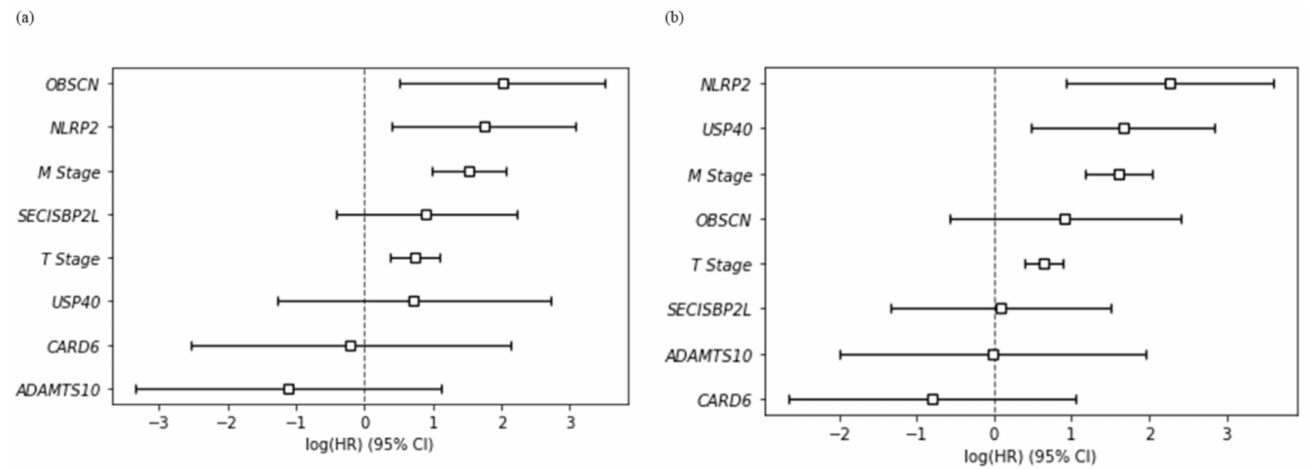
Figure 4. Multivariate forest plots on survival in TCGA_KIRC (Firehose Legacy) data by the mul- tivariate Cox regression analysis: ( a ) overall survival and ( b ) disease-free survival. CI, confidence interval; log(HR), hazard